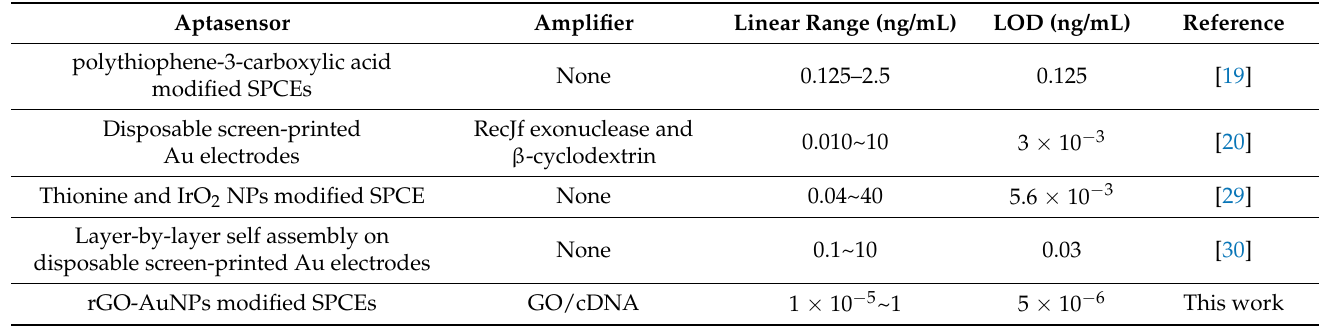
Figure 5. ( A ) DPV curves of aptasensor with different concentrations of OTA (0 pg/mL, 0.01 pg/mL, 0.1 pg/mL, 1 pg/mL, 10 pg/mL, 100 pg/mL, 500 pg/mL, 1 ng/mL, 2 ng/mL from lower to upper); ( B ) The trend of the ∆ i peak peak current with the concentration of OTA (calibration curve towards OTA detection). Table 1. Comparison of the analytical performance of different disposable electrochemical aptasensors for OTA detection.